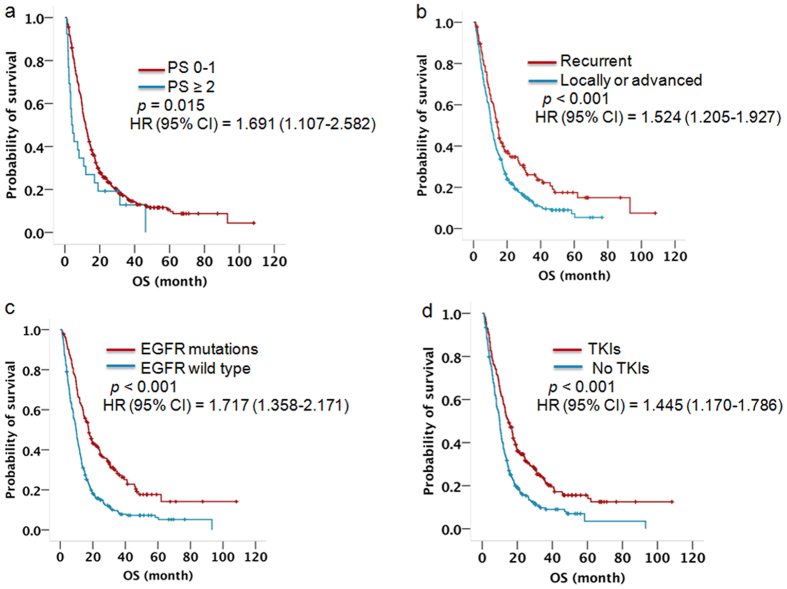
Kaplan-Meier survival curve for the 503 patients stratified by (a) PS score, (b) disease type, (c) EGFR status, (d) EGFR TKI therapy. P-value indicates significance levels from the comparison of survival curves using the Log-rank test.